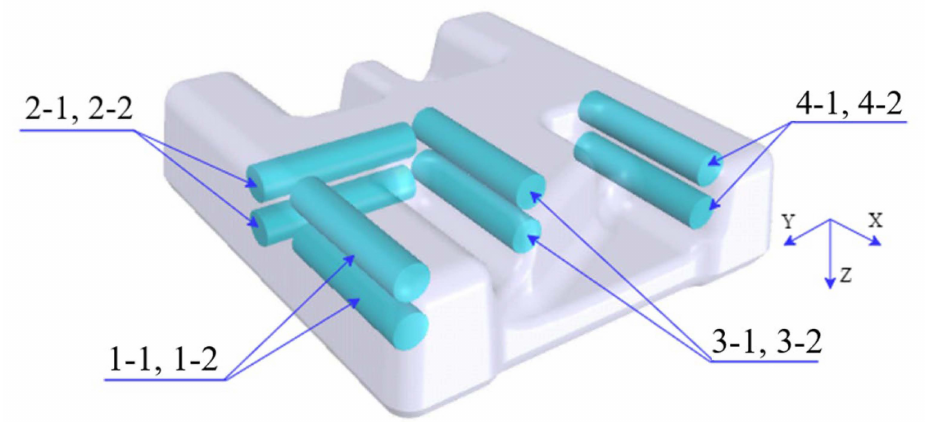
Figure 13. Schematic diagram of the sampling position of mechanical properties.